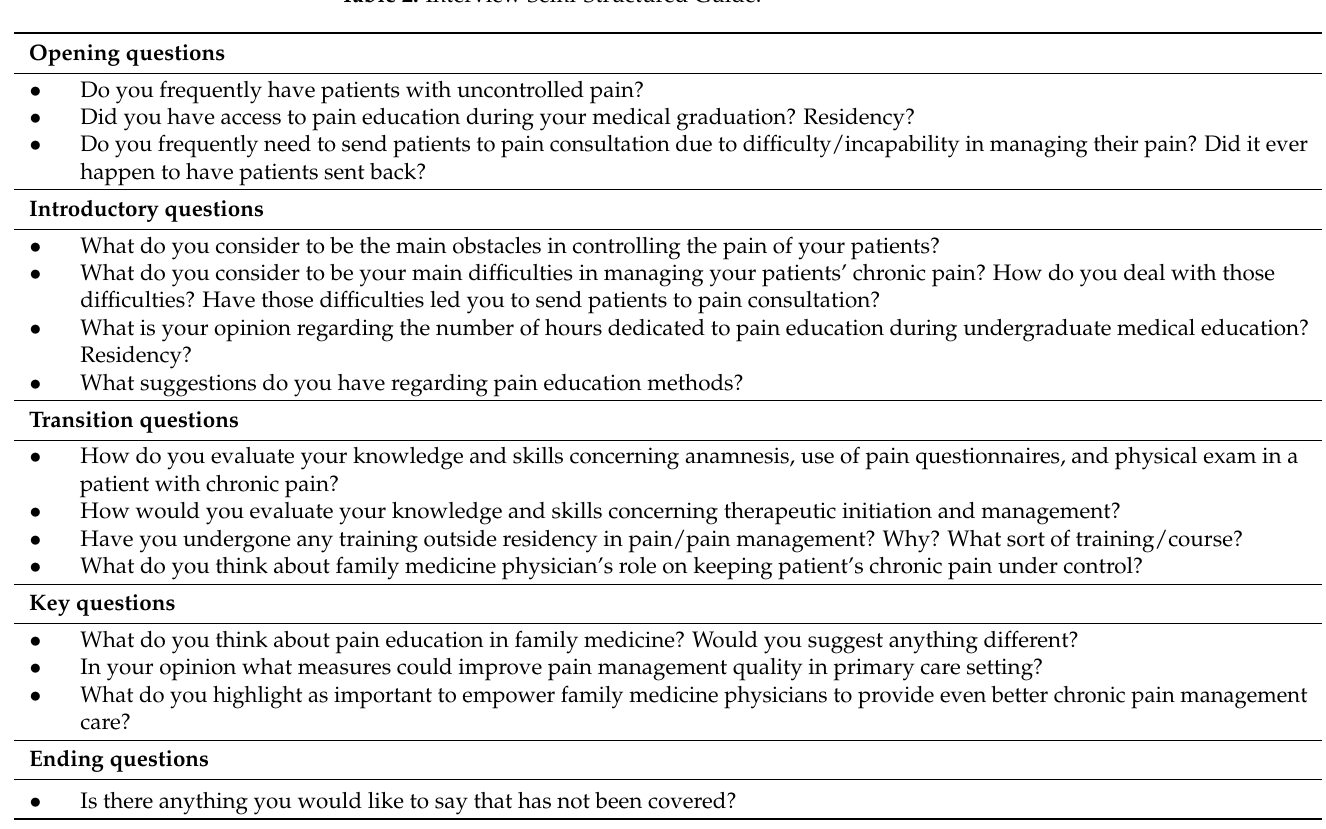
Table 2. Interview Semi-Structured